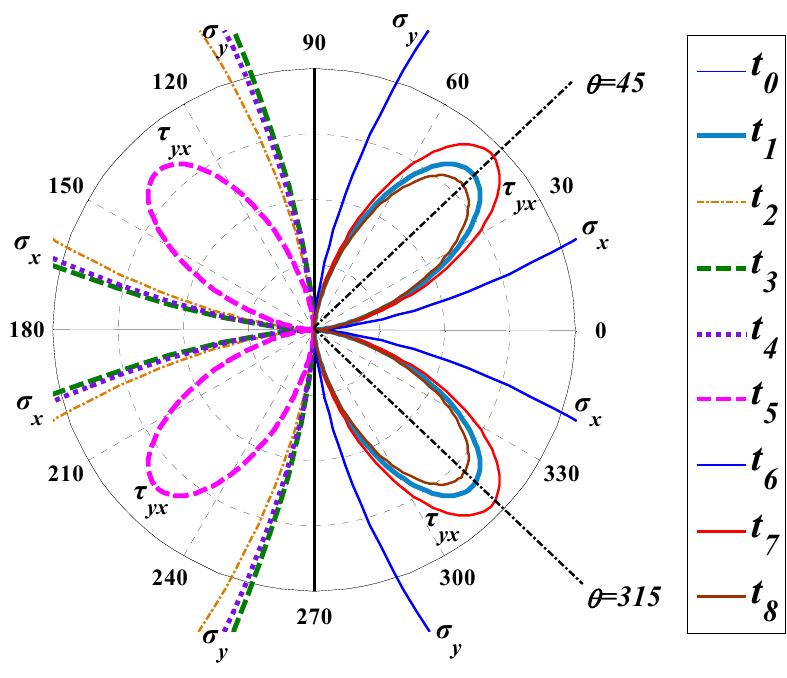
Figure 12. Polar coordinate diagram of changing the equivalent stress components due to the concentrated normal force and the concentrated tangential force from the piezoelectric vibration.